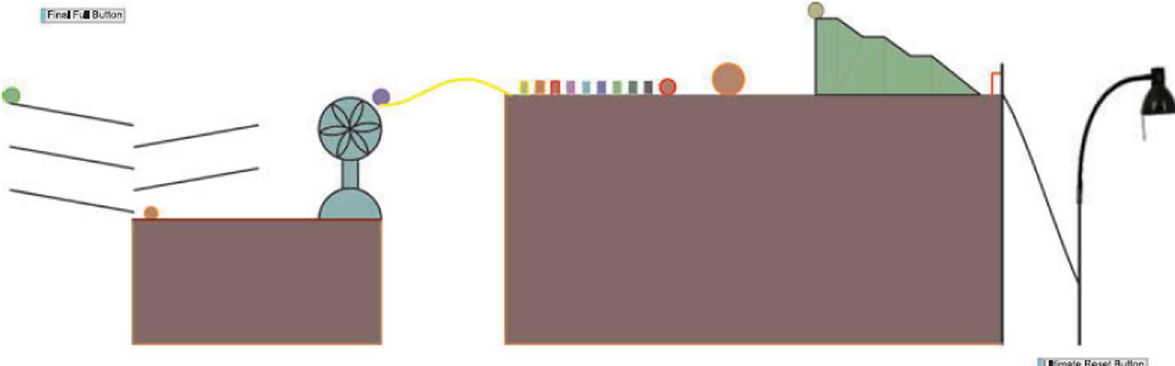
Fig. 5 Fan and Lightbulb Rube Goldberg machine (Sinclair & Patterson, 2018, p.